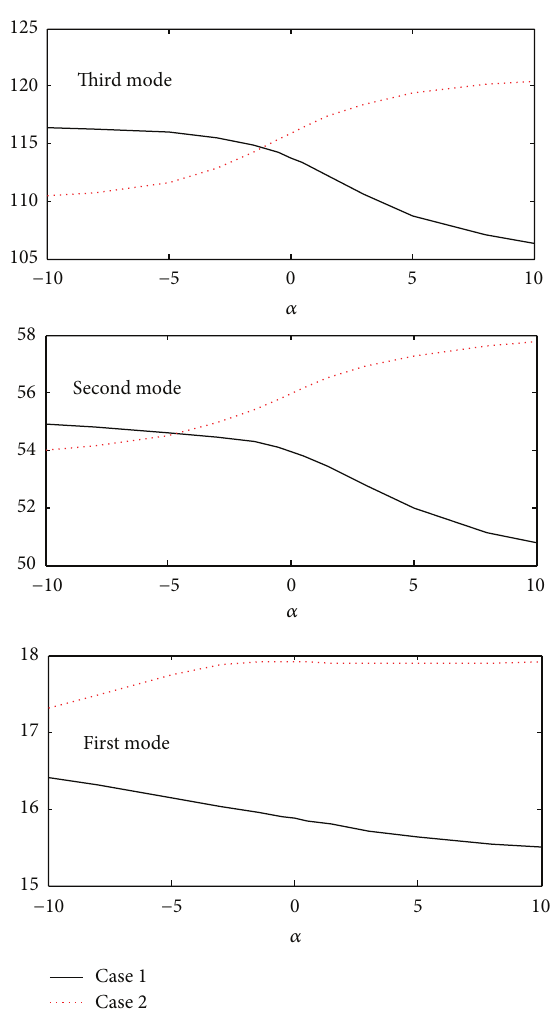
Figure 14: Variation of first three nondimensional natural frequen- cies of an axially FG beam with respect to 𝛼 ; boundary condition: C-F.